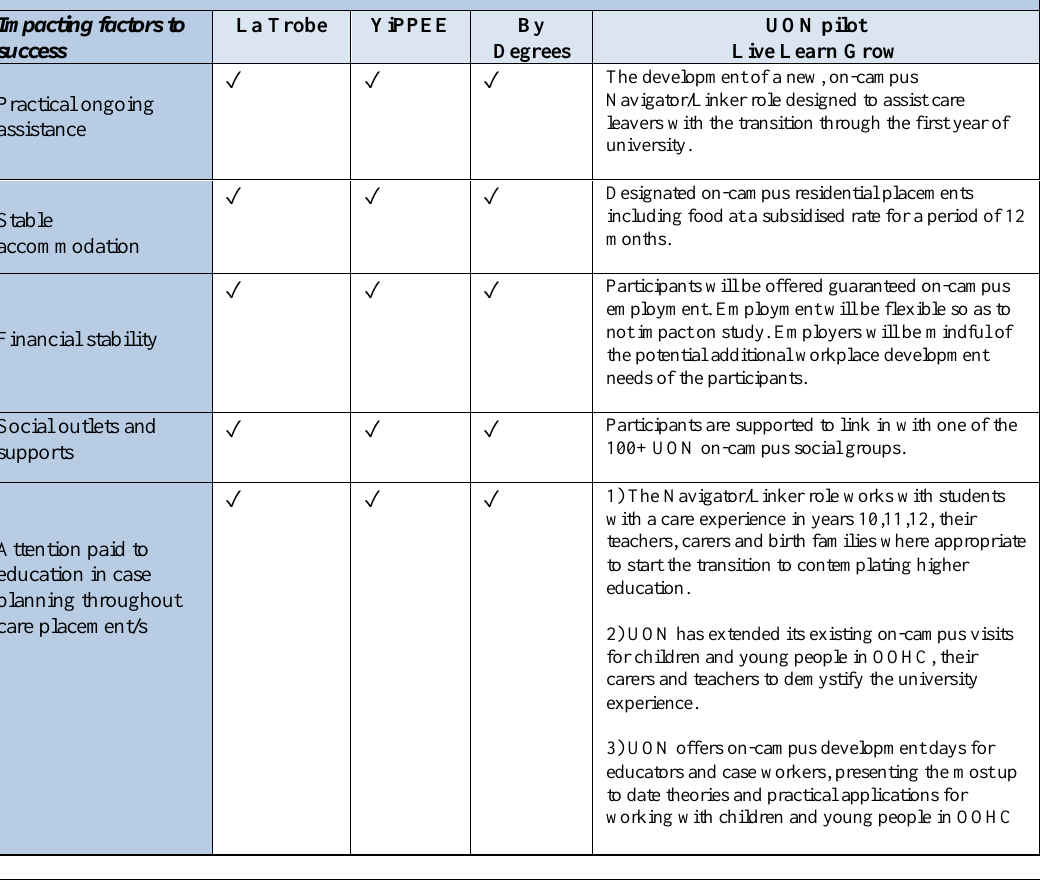
Table 1: Contemporary national and international studies into OOHC and higher education Contemporary national and international studies into OOHC and higher education Impacting factors to La Trobe YiPPEE By success Practical ongoing assistance